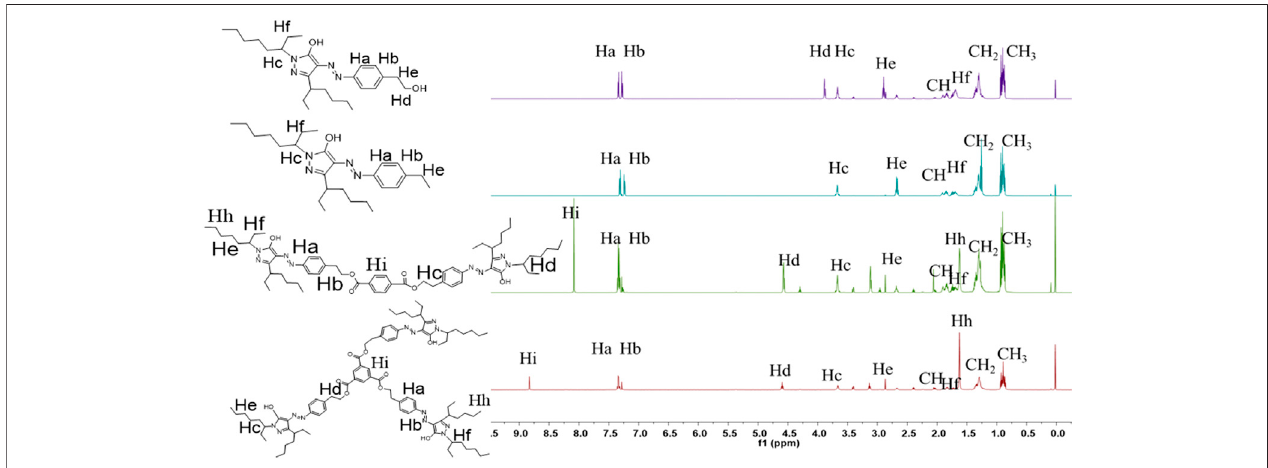
FIGURE 2 | 1 H NMR spectra of three synthesized dyes and